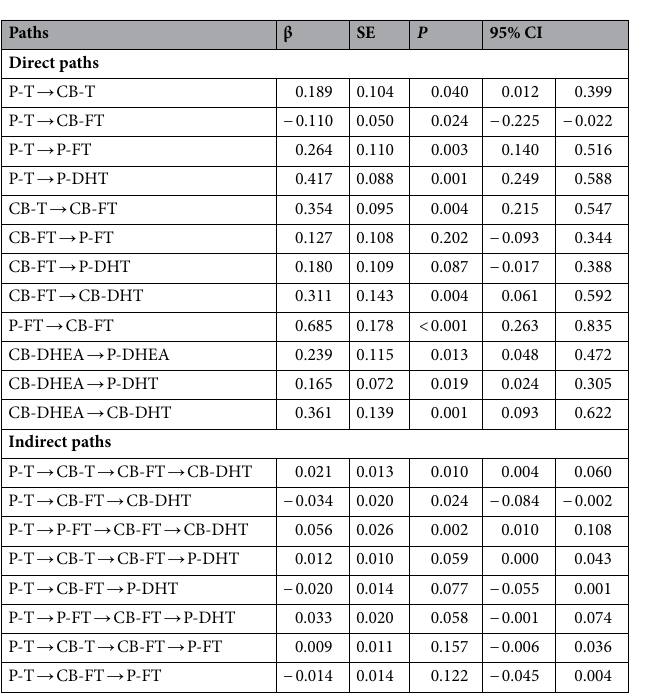
Table 3. Coefficients of association path models between prenatal androgens and cord blood androgens in male neonates. P-T prenatal testosterone, P-FT prenatal free testosterone, P-DHT prenatal dihydrotestosterone, P-DHEA prenatal dehydroepiandrosterone, CB-T cord blood testosterone, CB-FT cord blood free testosterone, CB-DHT cord blood dihydrotestosterone, CB-DHEA cord blood dehydroepiandrosterone.